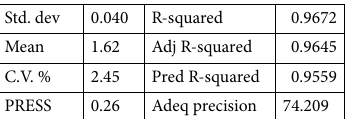
Table 3. Accuracy of proposed correlation.